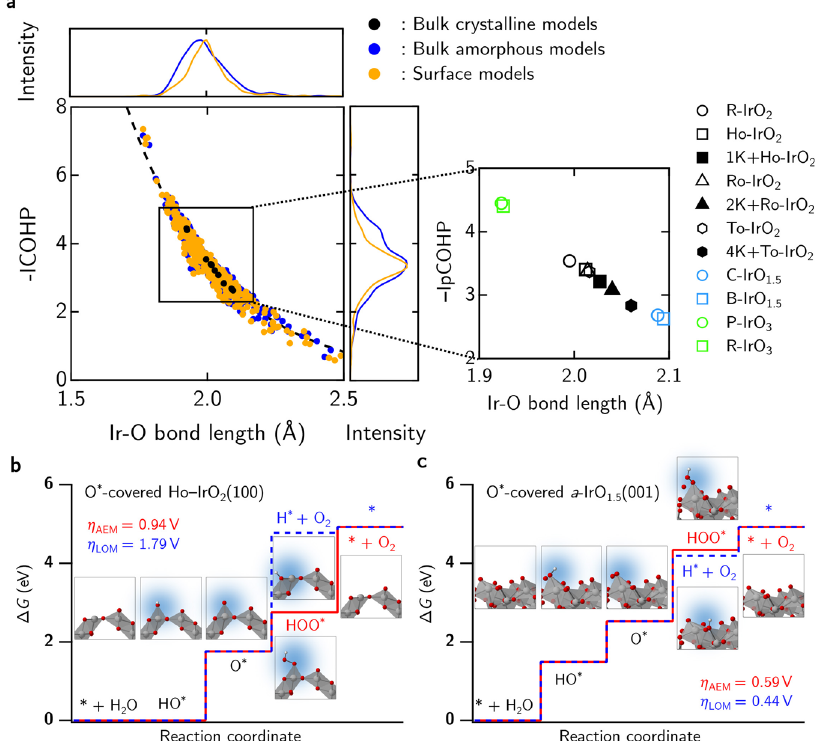
Fig. 6 Chemical and reaction steps analysis for oxygen evolution reaction on iridium oxides. a Scatterplot for − IpCOHP versus Ir – O bond lengths for bulk crystalline and amorphous models and the surfaces of amorphous iridium oxides. The detailed plot for all crytalline/nanoporous iridium oxide phases are shown in the inset. The Δ G diagrams for OER via the adsorbate evolving mechanism (AEM; in red) and the lattice oxygen mechanism (LOM; in blue) for b O * -covered Ho-IrO 2 (100), and c O * -covered a -IrO 1.5 (001). The corresponding atomic structures for each reaction step are also provided alongside the Δ G diagrams. The iridium, oxygen, and hydrogen atoms are depicted as gray, red, and white spheres,